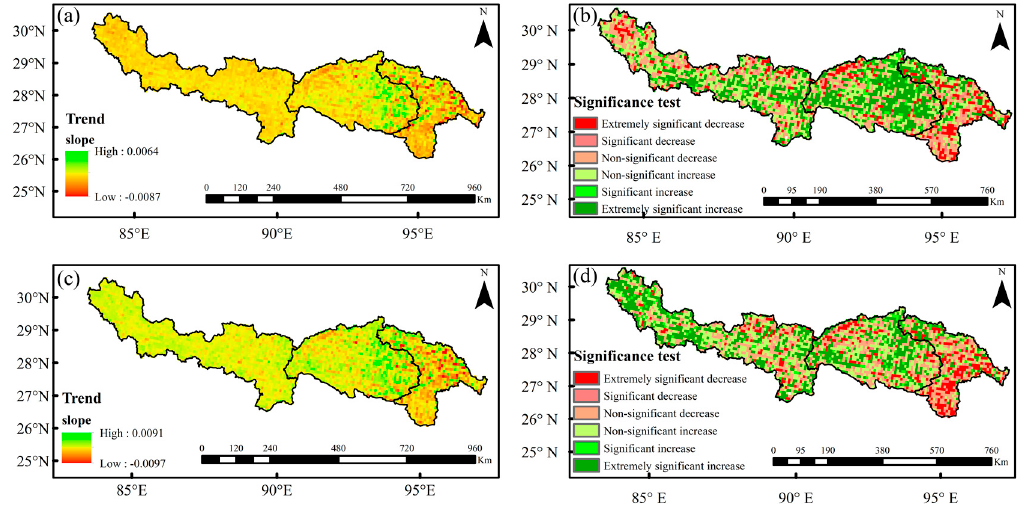
Figure 11. Annual ( a , b ) and growing season ( c , d ) spatial variations of NDVI with the significance test. Table 6. Area ratios of NDVI with different change trends.